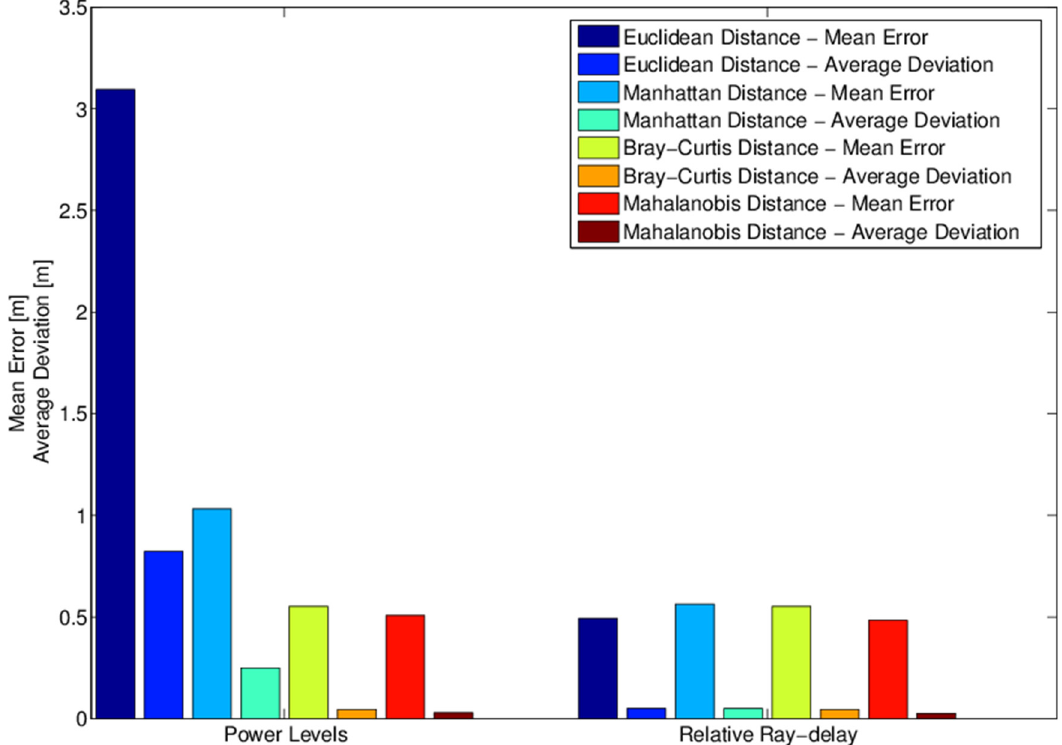
Figure 16. Case 1 results: Localization error when comparing power vs. delay detection methods with